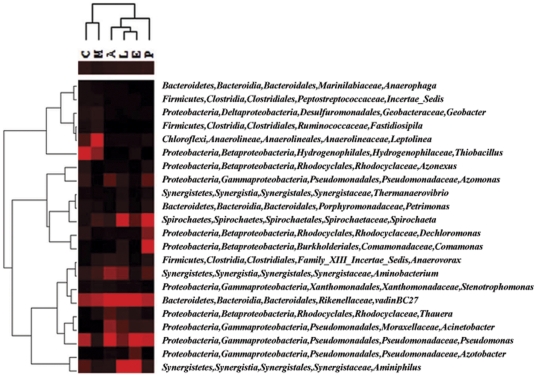
The predominant bacterial genera existing in common whose relative abundances were higher than 1.0% at least in one of the microcosms.The abbreviations were represent the control microcosm without electron donor amendment (C), or enriched with methanol (M), ethanol (E), acetate (A), lactate (L), or pyruvate (P).